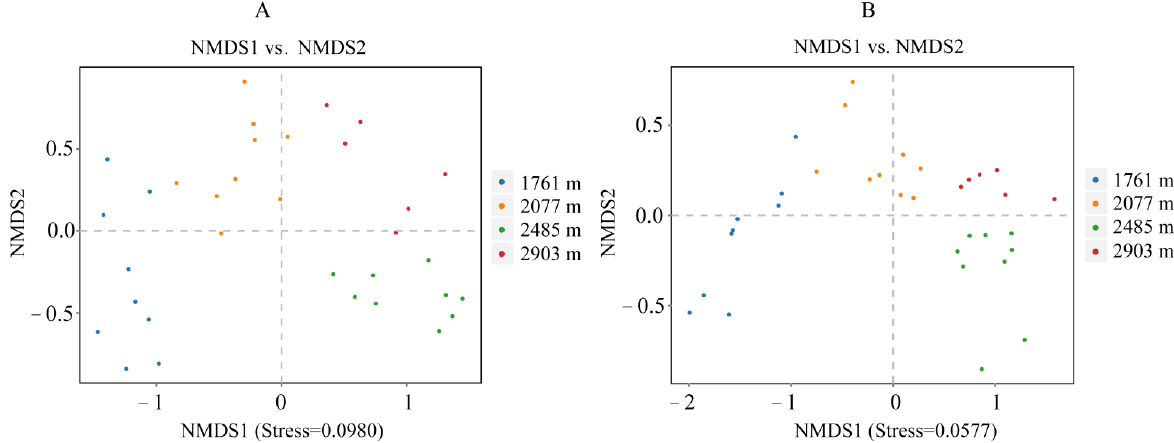
Figure 2. Non-metric multidimensional scaling analysis of soil fungal ( A ) and bacterial ( B ) communities at different elevations.